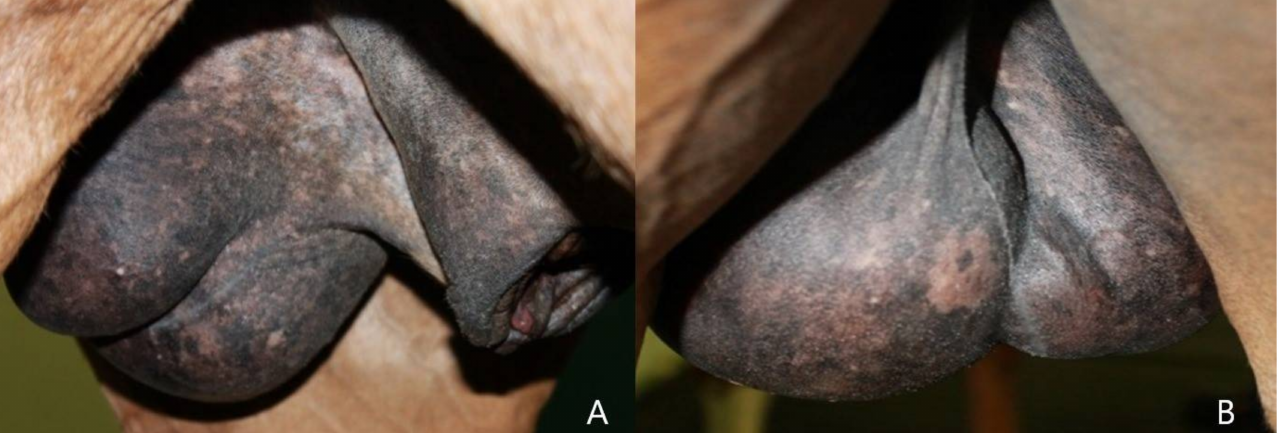
Figure 1. Medio-lateral ( A ) and caudo-cranial ( B ) view of the scrotum, showing an increase in the volume of the pathological testis (left) compared to the contralateral (right).